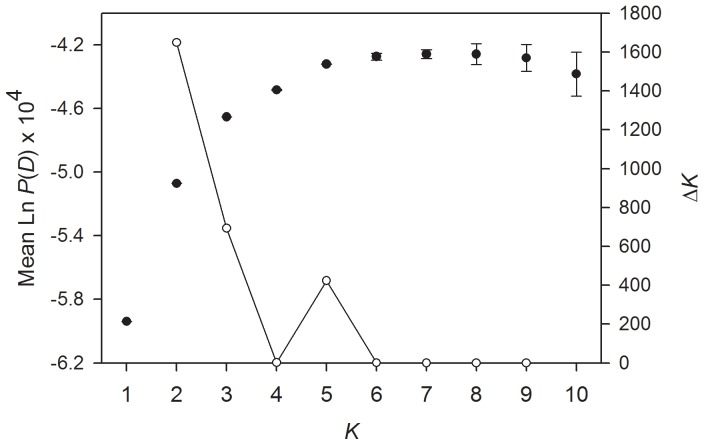
Results of the Structure analysis showing mean ± standard error Ln P(D) and ΔK values (filled and open circles, respectively) based on five replicates for each value of K, the hypothesized number of genetic clusters represented in the data.